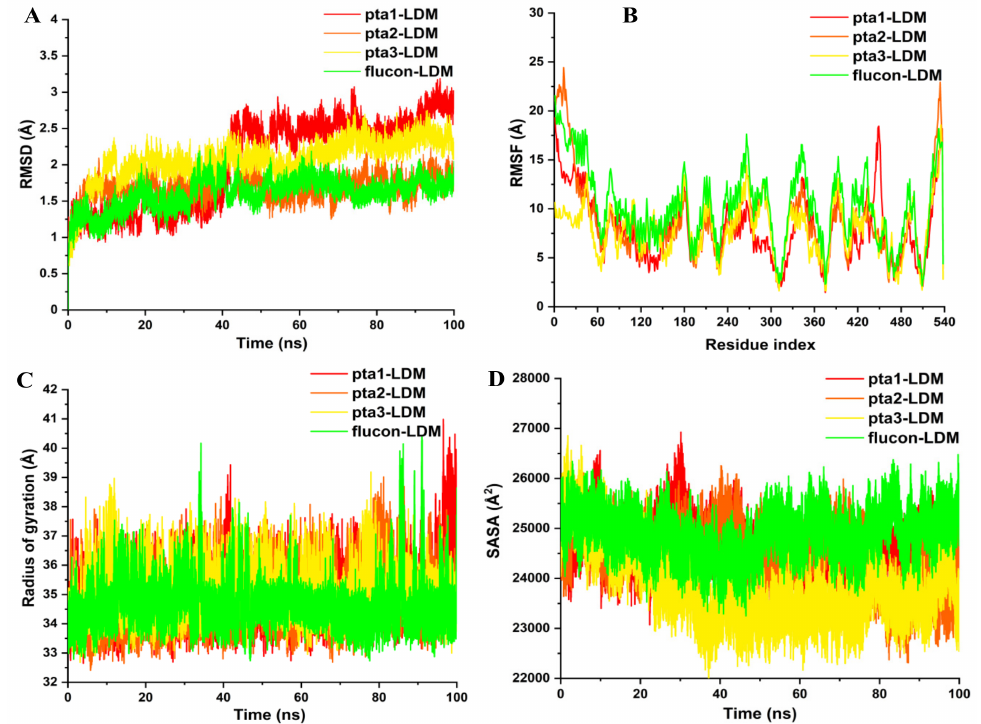
Figure 3. Structural dynamics of LDM enzyme-ligand complexes. ( A ) RMSD, ( B ) RMSF, ( C ) Rg values, and ( D ) SASA values of pta1-LDM, pta2-LDM, pta3-LDM, and fluconazole-LDM in Å across C α backbone atoms of all the four conditions calculated during the 100 ns of MD